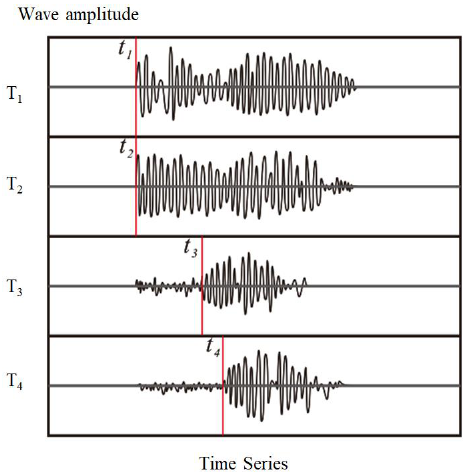
Figure 1. Waveforms of microseismic signals. T i and t i in order represent the data of the i -th sensor and the observed arrival time of the i -th sensor .